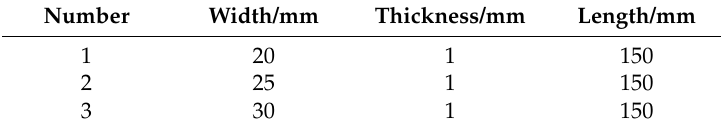
Table 2. The geometrical sizes of waveguide bars for simulation.